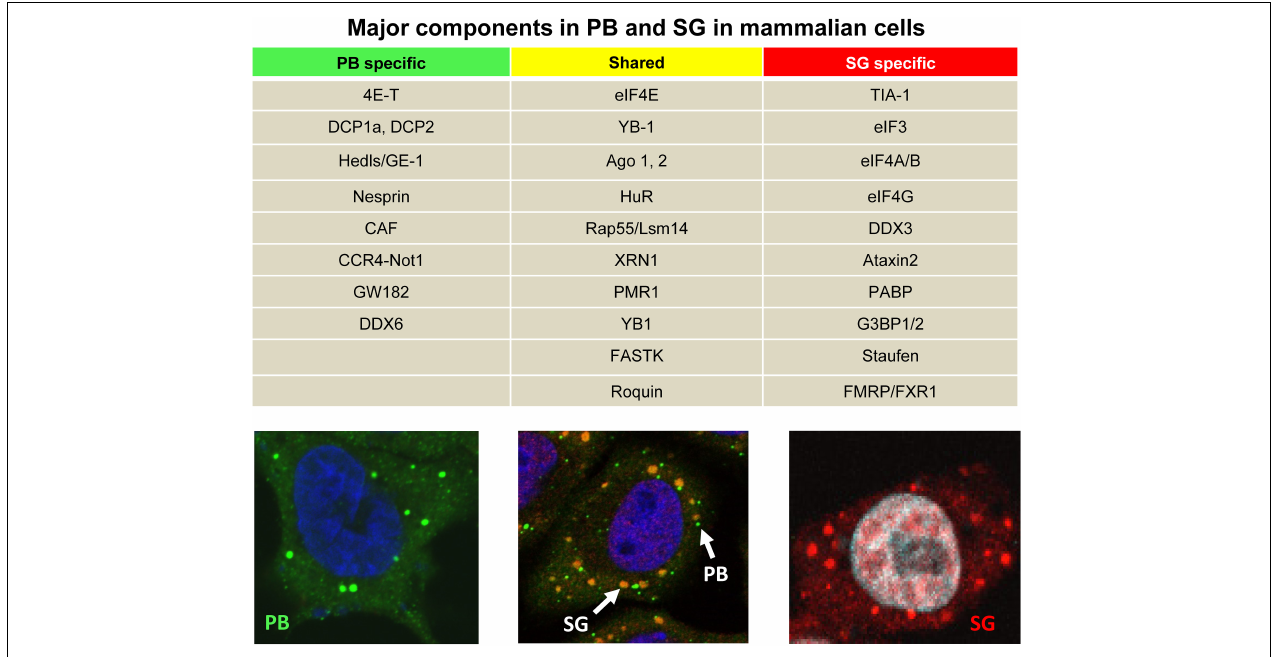
FIGURE 1 | Two major cellular RNA granules and their protein components. The table shows major specific or shared cellular protein components of PB and SG in mammalian cells. In the bottom panels, PB (green) and SG (red) are visible in HeLa cells after immunostaining with an anti-GW182 antibody under physiological conditions (left) or with an anti-TIA-1 antibody during stress induced by treatment with 0.5 mM NaAS 2 O 3 (arsenite or ARS) for 30 min (right) . Middle panel showing the HeLa cells under ARS stress were double stained with an anti-GW182antibody for PB (green) and an anti-TIA-1 antibody for SG (yellow).